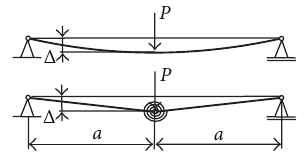
(cid:4) b , ( i = 1, N ) may be considered as the third system, which is denoted further by the superscript M